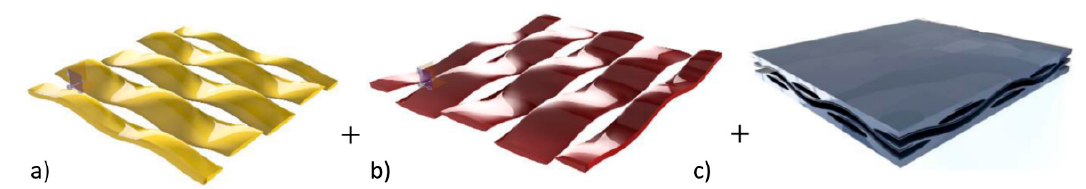
Figure 4. Projectile geometry: ( a ) 9 mm Parabellum, ( b ) dimensions, ( c ) discrete model.